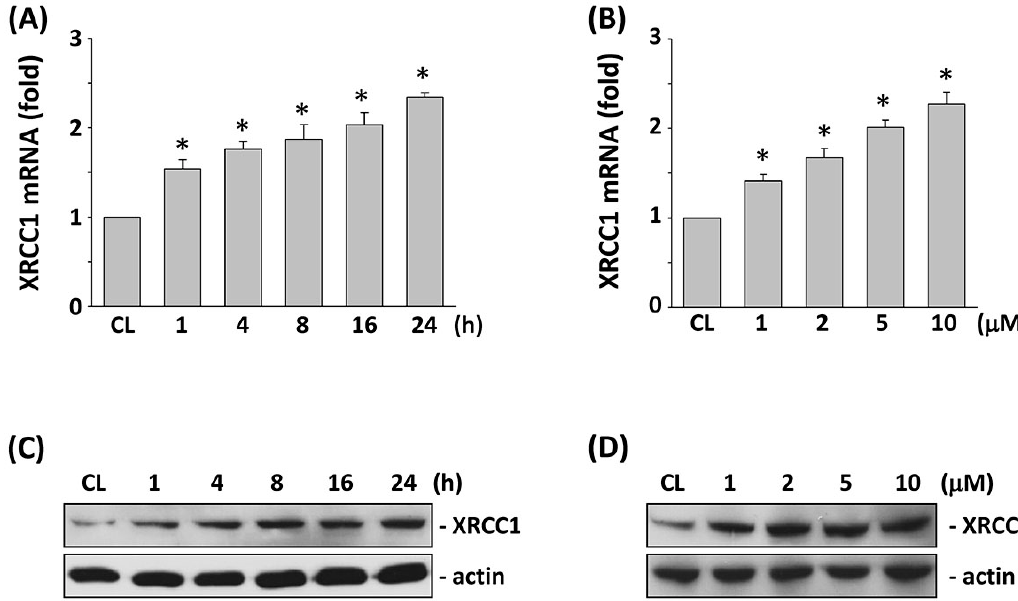
Figure 1. Stimulation with 5-FU increased XRCC1 mRNA and protein levels in HCT-116 cells. HCT-116 cells were kept as controls (CL) or stimulated with 5 μ M 5-FU at the indicated time periods ( A , C ), or stimulated with different doses of 5-FU for 24 h ( B , D ). ( A , B ) mRNA expressions of XRCC1 were determined by real-time polymerase chain reaction (PCR) analysis and normalized to 18S rRNA. The results are shown as mean ± standard error of the mean (SEM). * p < 0.05 versus CL. ( C , D ) XRCC1 protein expressions were determined by Western blot analysis.